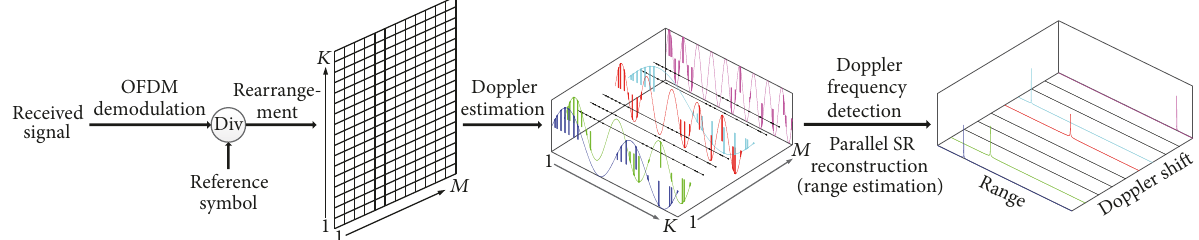
Figure 4: The flow chart of the range-Doppler processing.